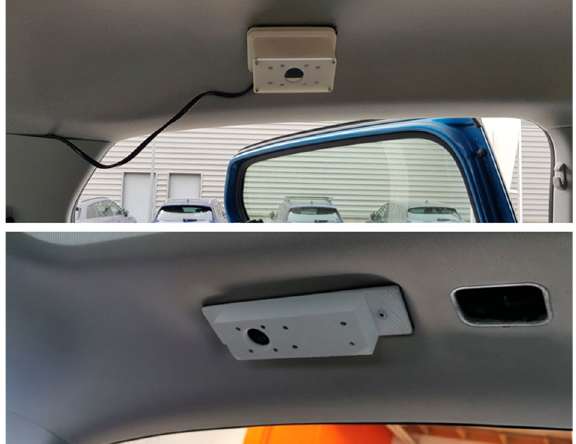
Fig. 7 Camera module installations in the SEAT concept car (top) and Aalto research vehicle